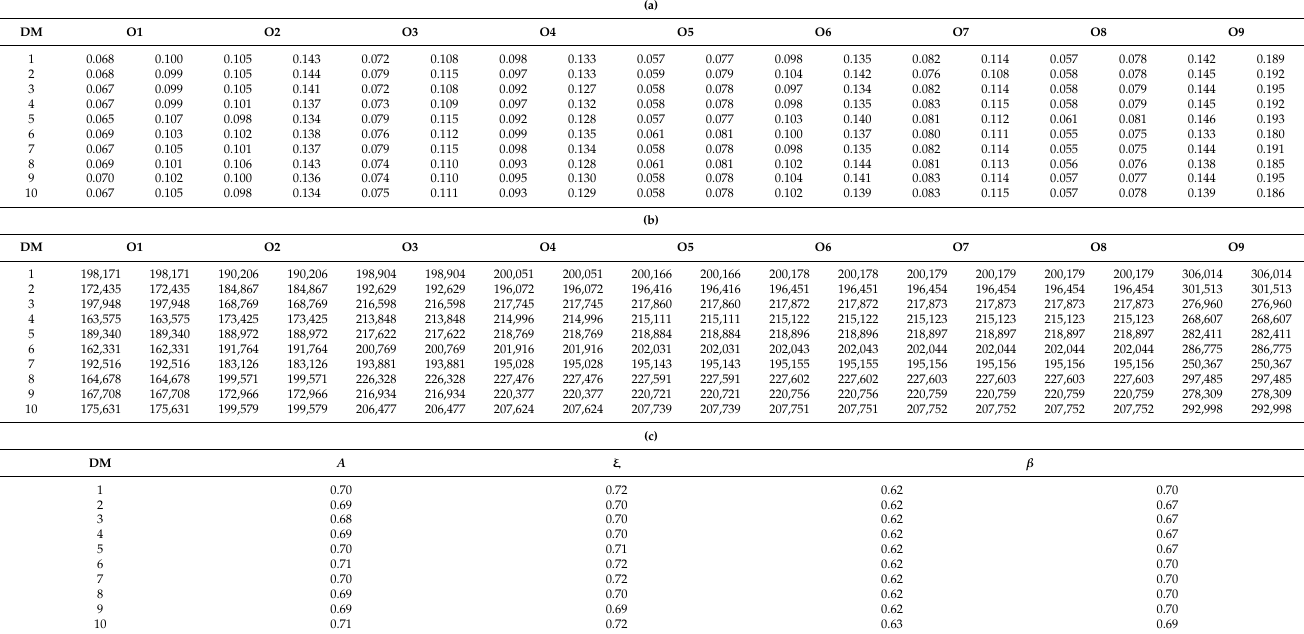
Table A4. The updated (a) weights after the consensus round, (b) veto thresholds after the consensus round, and (c) credibility thresholds after the consensus